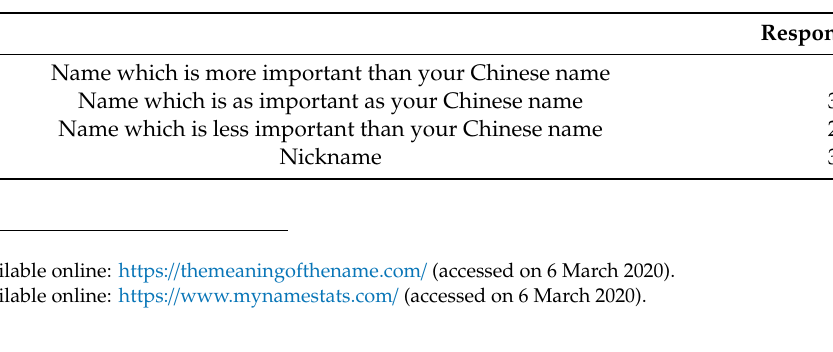
Table 2. The perception of one’s own English